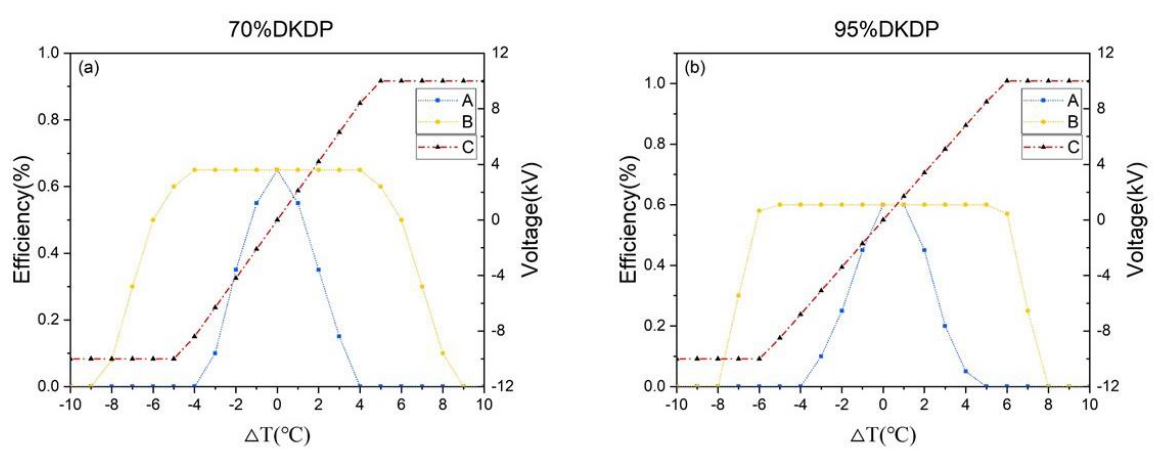
Figure 1. Calculated OPA efficiencies obtained via ( a ) 70%- and ( b ) 95%-deuterated DKDP versus temperature and com- pensation voltage. Line A represents the OPA efficiency without compensation, Line B indicates OPA efficiency where the phase mismatch is compensated, and Line C represents the compensation voltage.